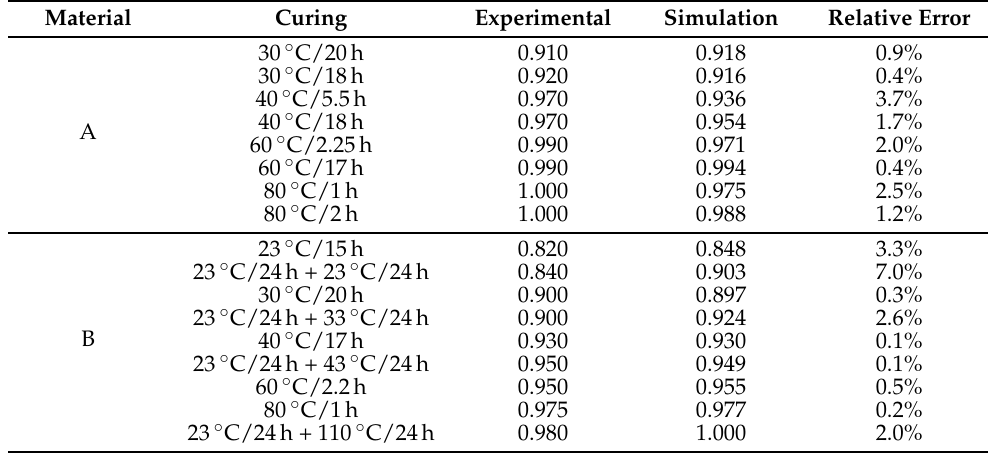
Table 6. Validation of the determined parameters for materials A and B by simulating curing protocols in